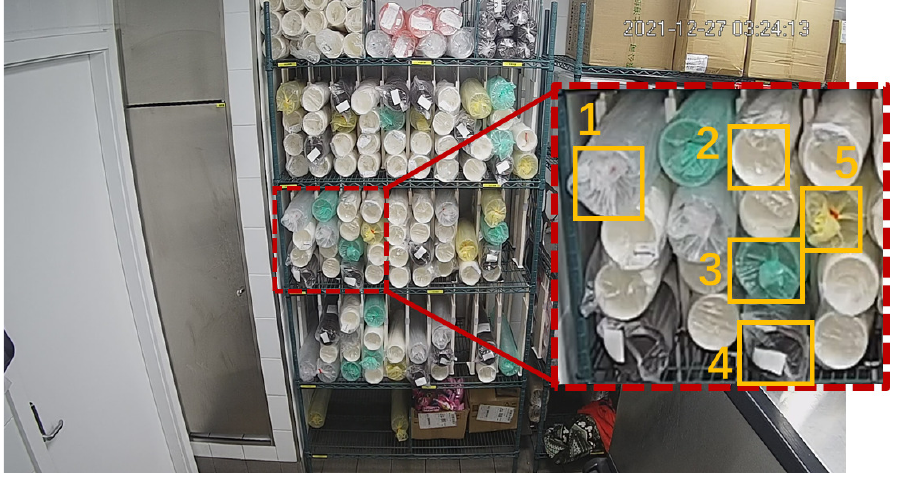
Figure 5. Cup class definition. Table 3. Cup class